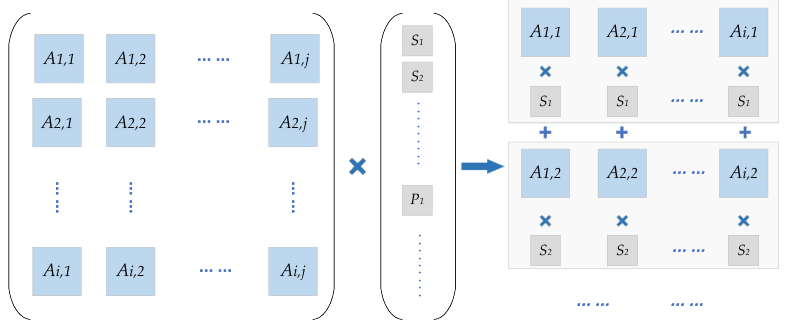
Figure 10. Parallelism improvement of Parities P 2